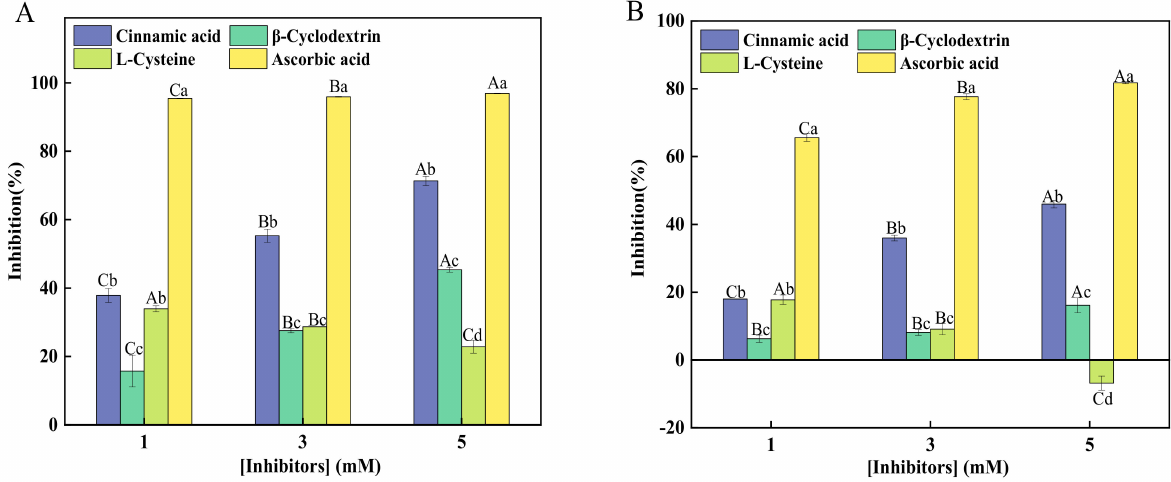
Figure 1. Effects of different inhibitors on the activities of sPPO ( A ) and mPPO ( B ) in ‘HuJingMiLu’ peach fruit. Inhibitor concentrations studied in this experiment included 1, 3, and 5 mM. Enzyme activities were determined using CA as the substrate. Different lowercase letters indicate that the inhibitory effects of different inhibitors at the same concentration are significantly different; different capital letters indicate that the inhibitory effects of the same inhibitor at different concentrations have significant differences ( p <